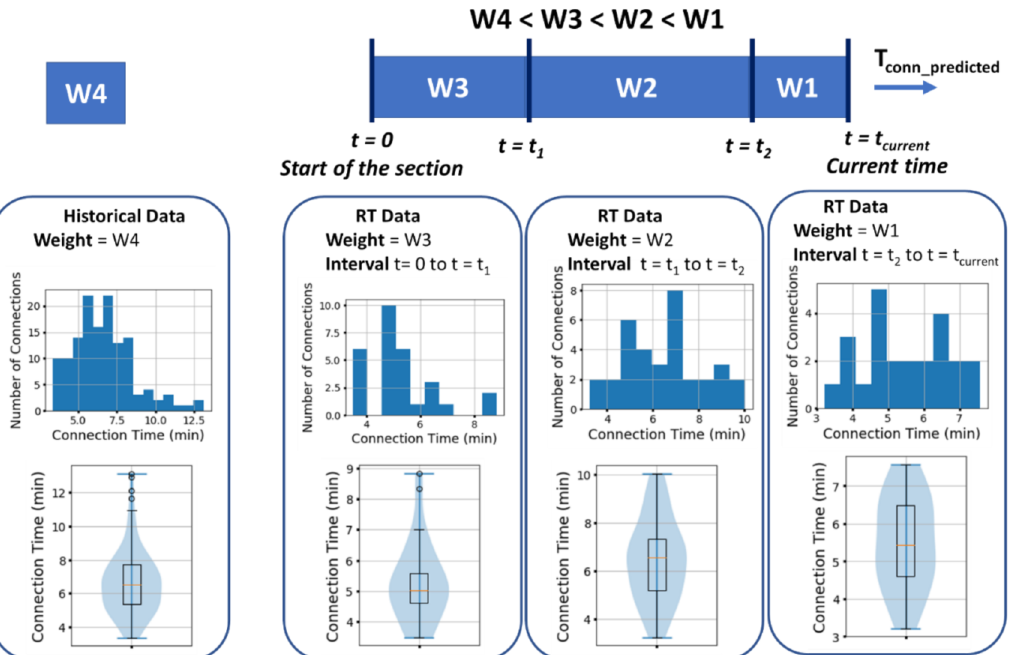
Figure 8. Adaptive weighted scheme for combining data collected at different times (for average connection time approximation).